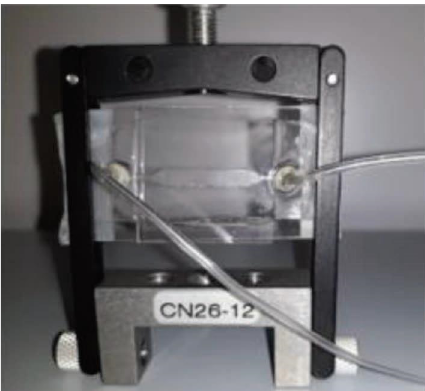
Figure 1: Polydimethylsiloxane channel with an inlet and